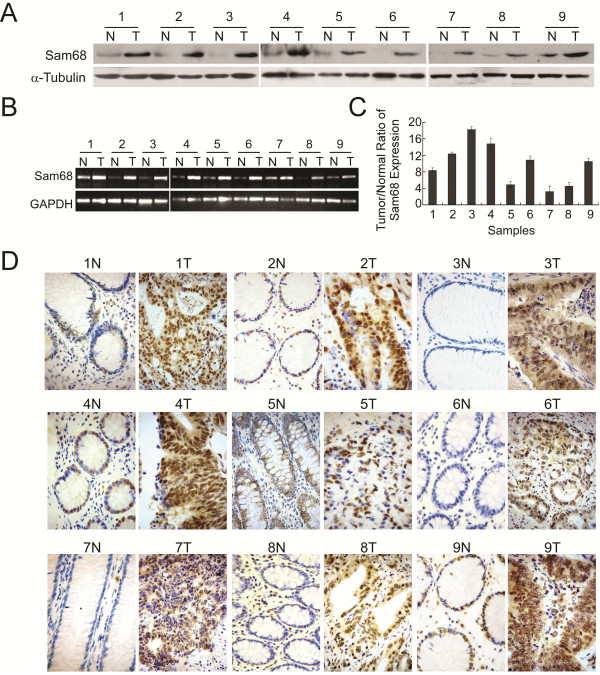
Sam68 is upregulated in primary colorectal cancer (CRC) tissues compared with the adjacent normal tissues. (A, B) Analysis of Sam68 mRNA expression in primary CRC tissues (T) and the paired adjacent normal tissues (N) by RT-PCR (A) and Q-PCR (B). GAPDH was used as loading control. (C, D) Analysis of Sam68 protein expression in primary CRC tissues and the paired adjacent normal tissues by Western blotting (C) and immunohistochemistry (D).